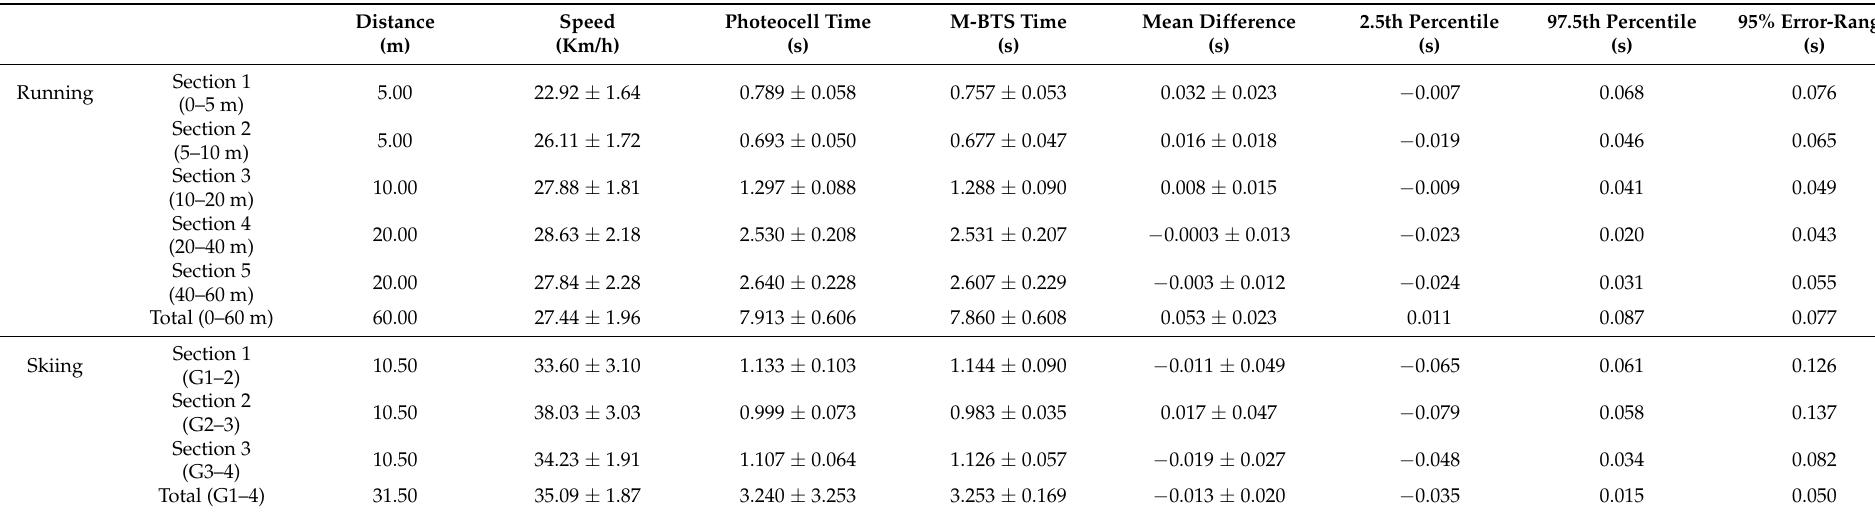
Table 1. Mean difference of the time obtained through the M-BTS against the actual time obtained from